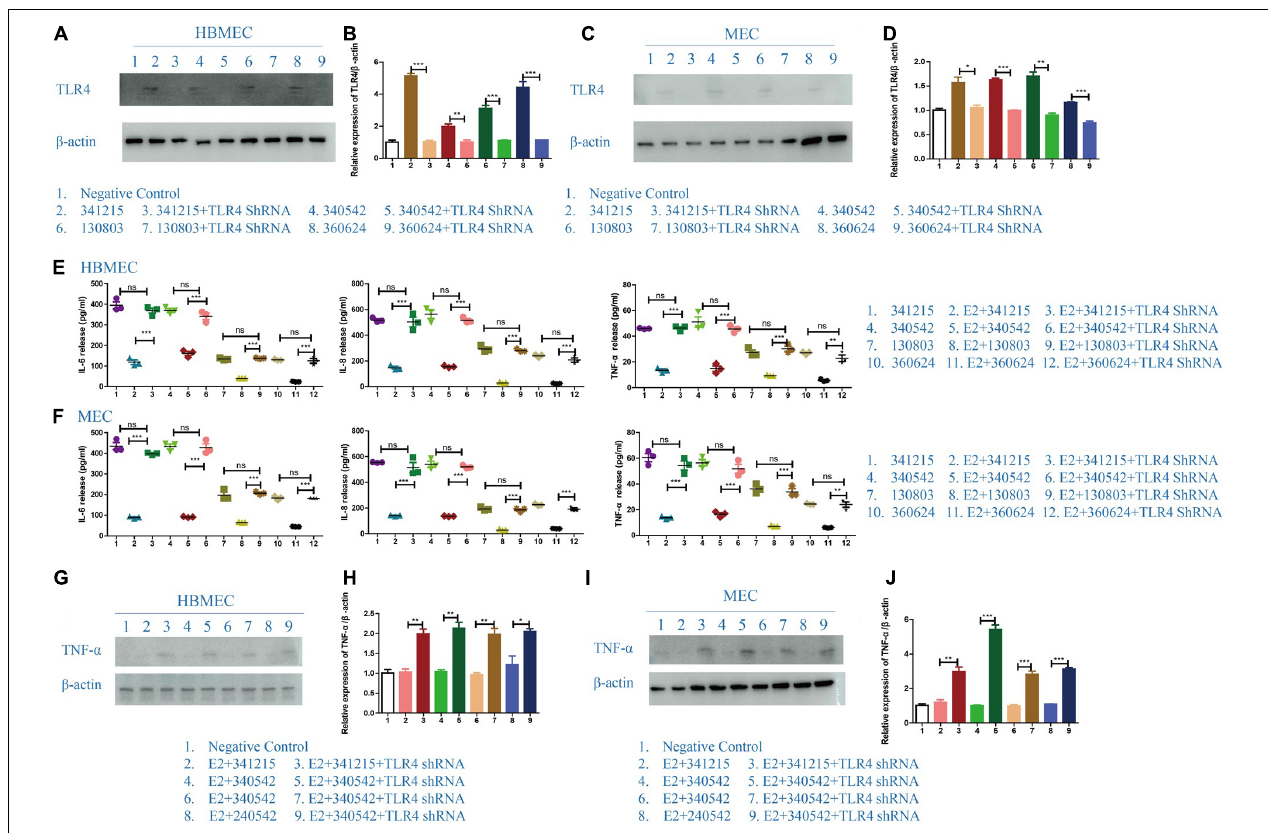
FIGURE 5 | The effect of TLR4 on the role of E2 in Neisseria meningitidis -infected cells. (A–D) TLR4 shRNA was transfected in to HBMECs (A) and MECs (C) infected with N. meningitidis . The cells infected with N. meningitidis without TLR4 shRNA transfection and the cells transfected with negative control were used as controls. Proteins were extracted and the level of TLR4 was detected using western blotting. β -actin was used as the internal reference. The changes in protein levels in HBMECs (B) and MECs (D) were analyzed using Image-J software, and the gray values were analyzed statistically using GraphPad Prism software. (E,F) A TLR4 shRNA was transfected into E2- N. meningitidis co-stimulated HBMECs (E) and MECs (F) . The E2- N. meningitidis co-stimulation experimental group without shRNA transfection and the experimental group only infected with N. meningitidis were used as controls. The supernatants of the cells were collected for ELISA assays, and the levels of IL-6, IL-8, and TNF- α in the supernatants were detected. (G–J) HBMECs (G) and MECs (I) were treated as shown. The expression of TNF- α was detected using western blotting. β -actin was the internal reference. The changes in protein levels in both cells (H,J) were analyzed as above. * P < 0.05, ** P < 0.01, *** P <